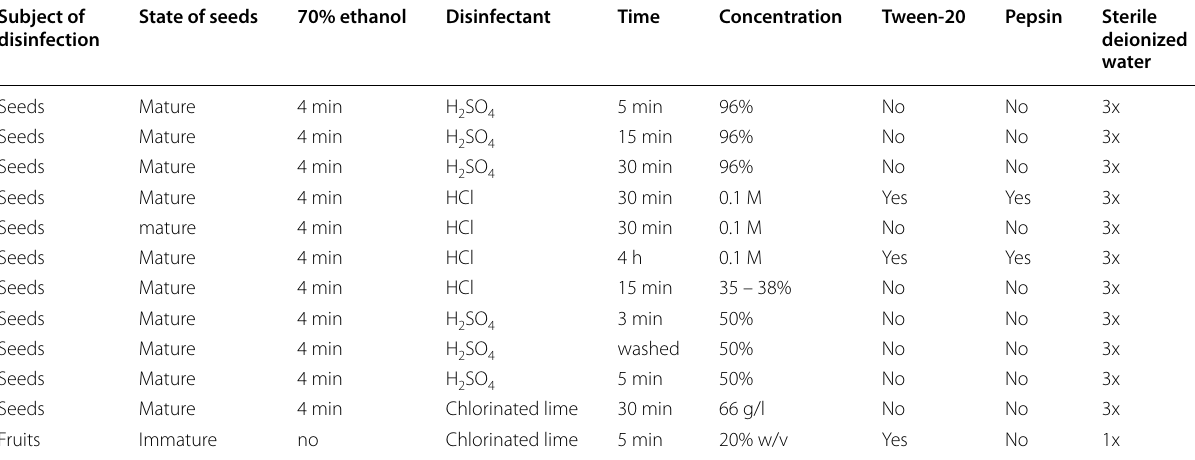
Disinfection and scarification treatment of Vanilla planifolia seeds prior to sowing. Tween-20 (1 drop per 200 ml) and pepsin (0.5 g/100 ml, porcine gastric mucosa, 250 U/mg, Sigma-Aldrich) were added into disinfection solution of selected treatments as